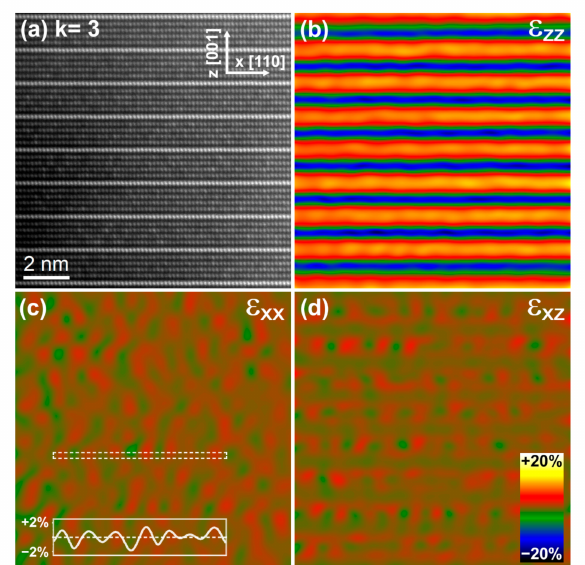
Figure 7. ( a ) High-resolution HAADF-STEM image of the k = 3 term obtained from aligning and averaging a series of 10 short-exposure images. The zig-zag modulation is barely visible. ( b – d ) Corresponding ε zz , ε xx , and ε xz strain maps obtained by GPA. The inset in panel ( c ) is the line profile of the ε xx strain component extracted along the white dashed box. The color bar gives the change in